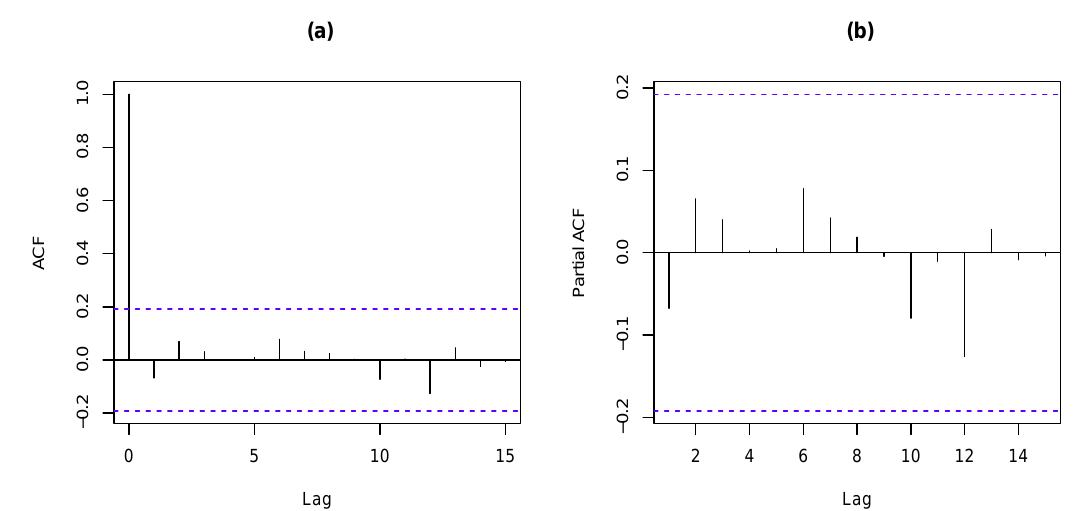
Figure 10. Pearson residual analysis: ( a ) ACF, ( b )